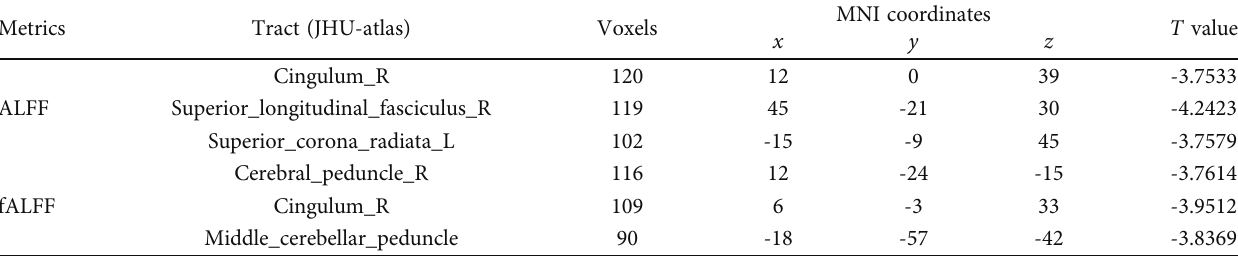
Table 2: Regions of WM showing abnormal ALFF and fALFF in patients with TIA compared with HCs.